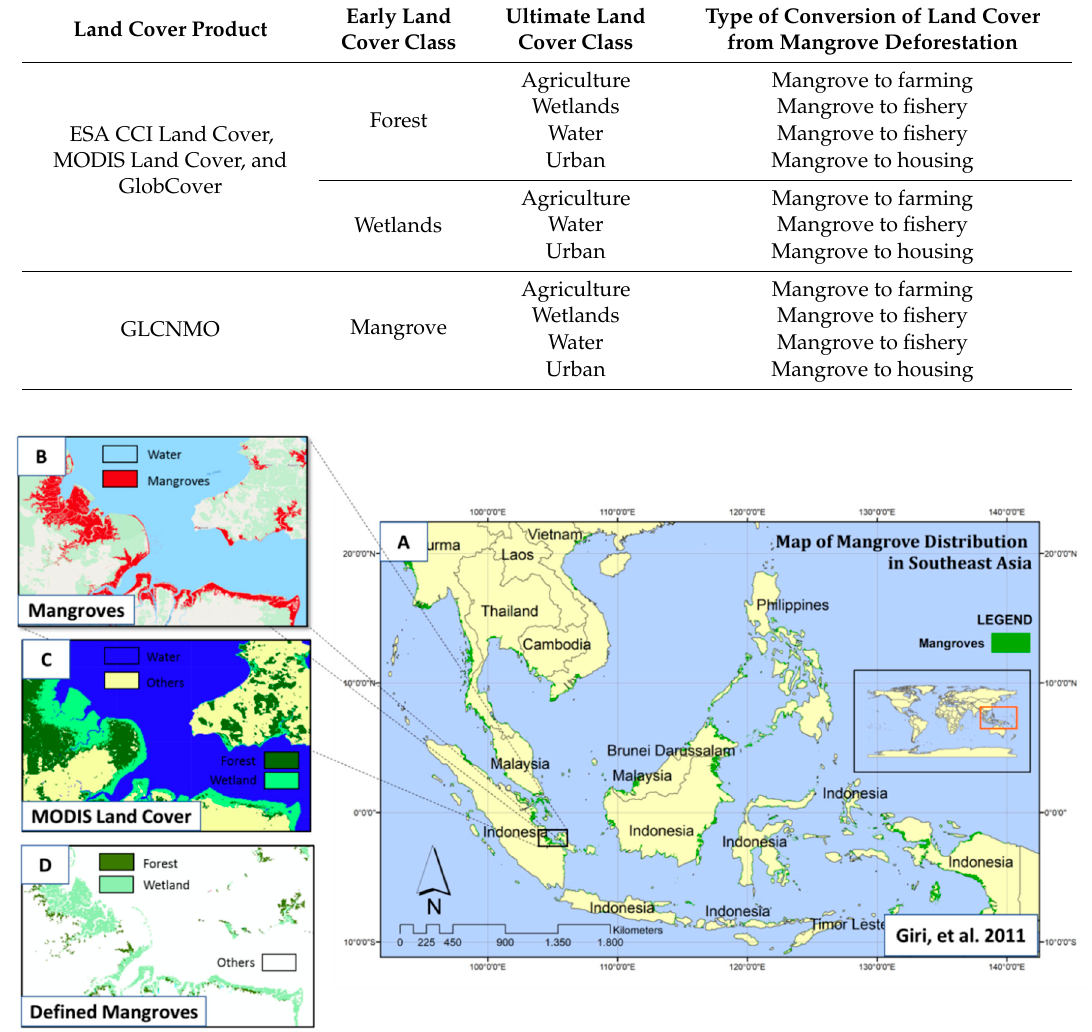
Table 5. Estimation of each type of land cover conversion in mangrove forest areas.